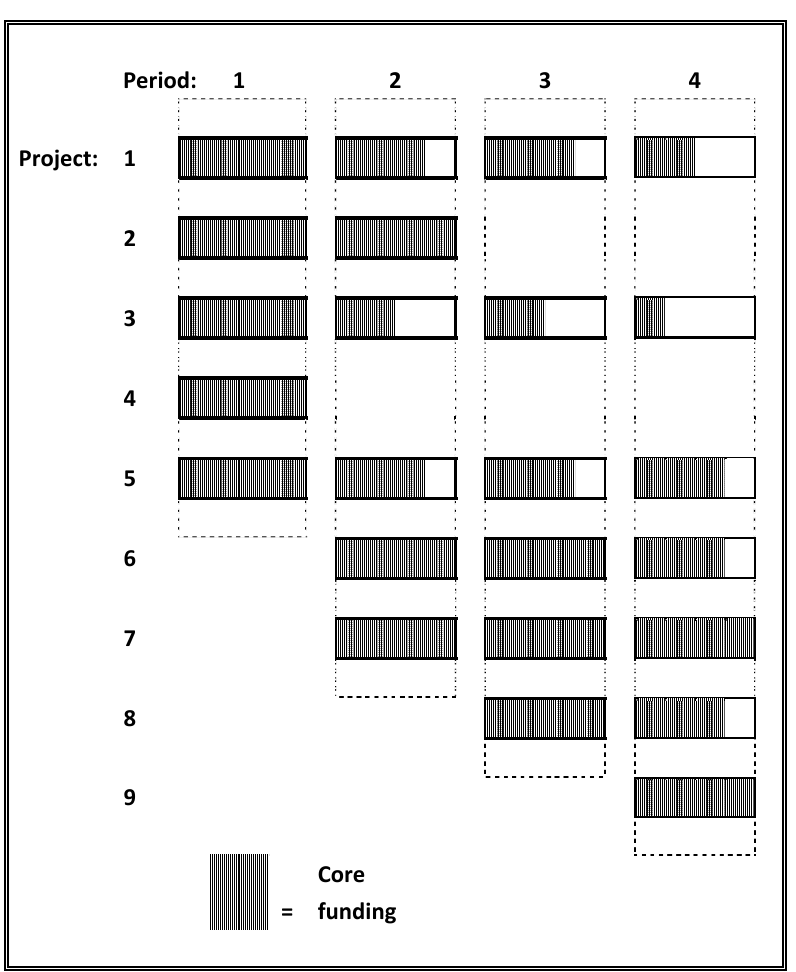
Figure 2. Illustration of a funding programme over four periods.